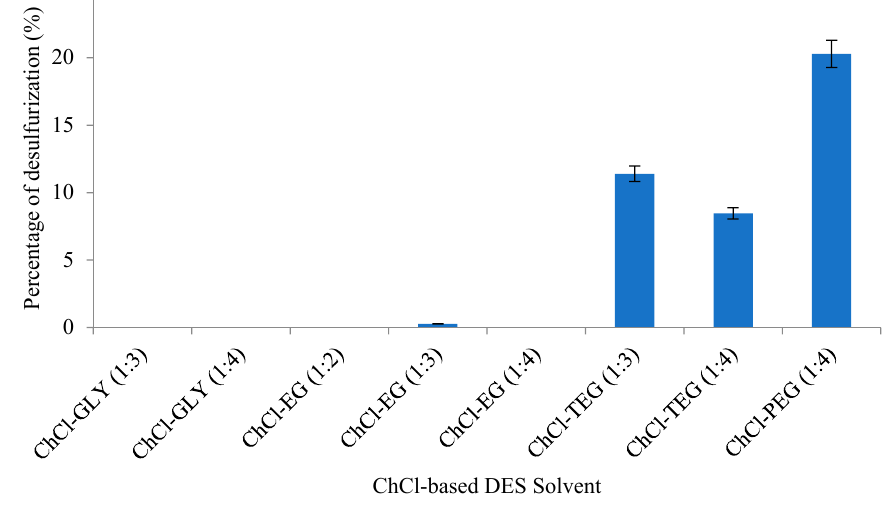
Figure 8. Desulfurization by selected DESs in model oil at 25 ◦ C. The DES / model oil (MO) ratio in the mixtures was 1:5, and the graphene oxide (GO) and H 2 O 2 dosages were 1:25 and 6:1, respectively.